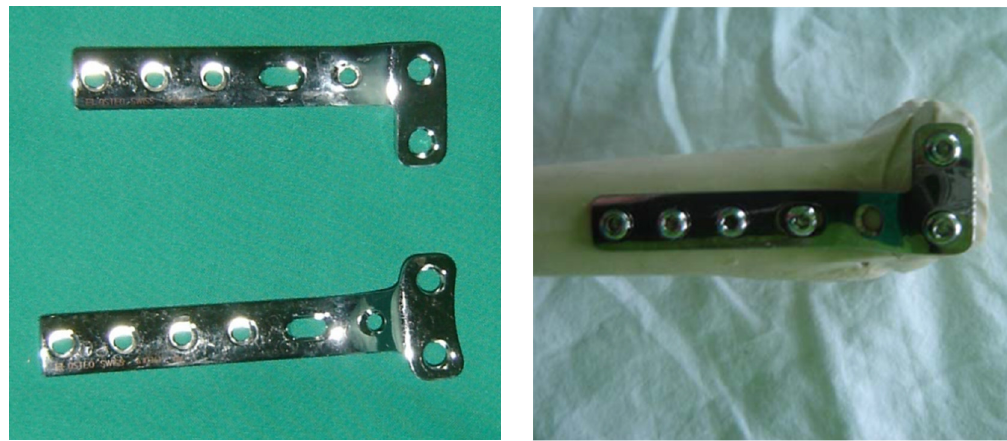
Figure 4. L Plate internal implant system. Appl. Sci. 2020 , 10 , x FOR PEER REVIEW